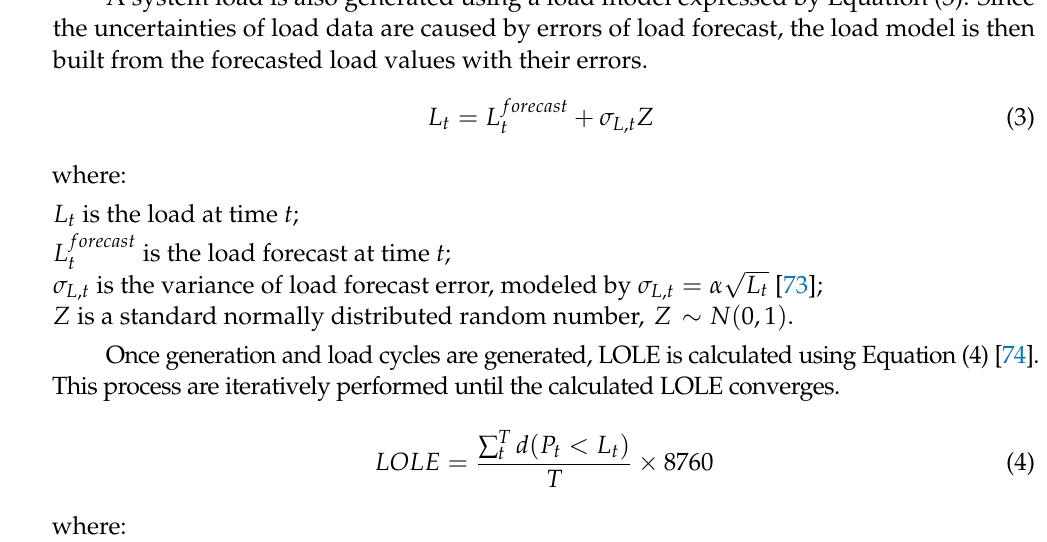
Figure 4. Operating cycles of all considered generating units.